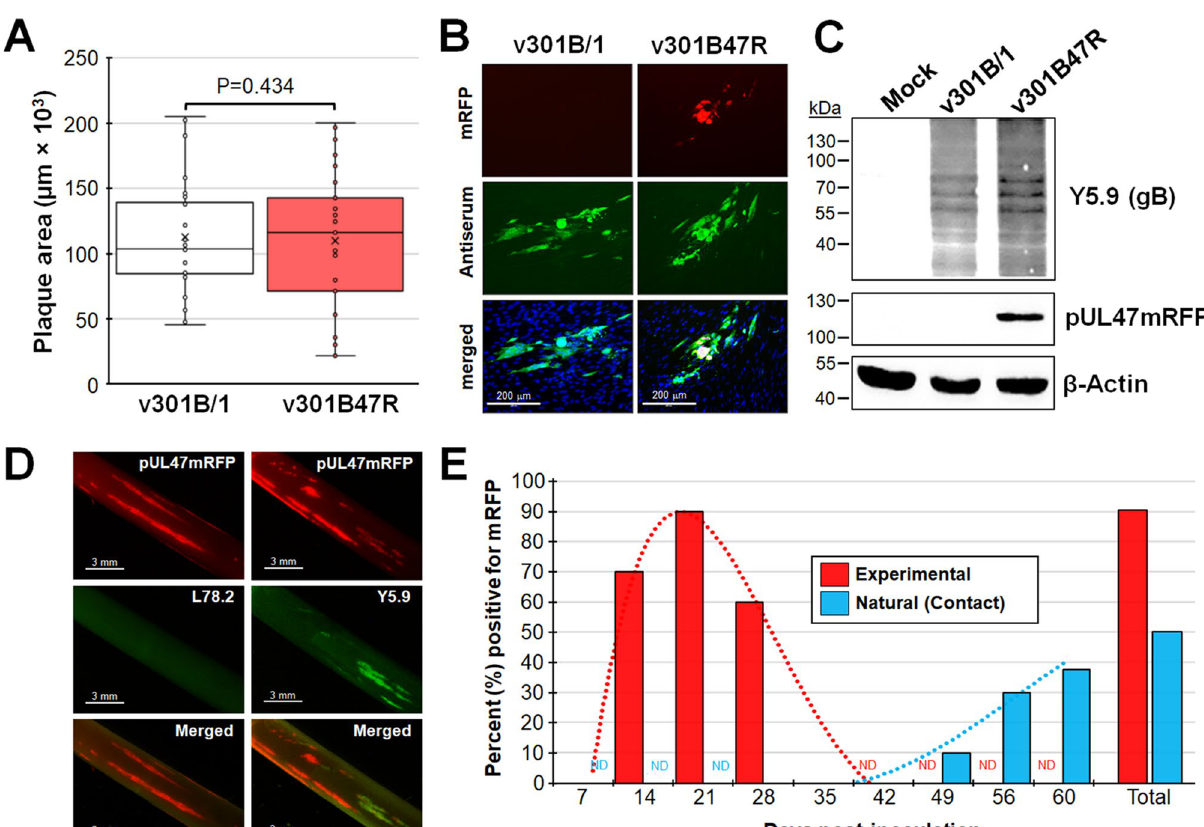
Figure 2. Replication and fluorescent protein expression in tissue culture cells. ( A ) Mean plaque areas (n = 25) of viruses reconstituted from r301B/1 and r301B47R were measured and the results are shown as box & whisker plots. There were no significant differences in plaque sizes between the two viruses using Student’s t tests. ( B ) Representative plaques for v301B/1 and v301B47R are shown. Plaques were stained with polyclonal chicken anti-GaHV-3 antibody and goat anti-chicken-IgY Alexa488 (green) was used as secondary antibody to identify plaques. Fluorescent expression of mRFP (red) was directly visualized and cells were counterstained with Hoechst 33342 to visualize nuclei. ( C ) Western blotting for pUL47mRFP using anti-mRFP antibody. The anti-GaHV-3 antibody Y5.9 31 was used to show the relative level of infection in the cultures. Antibody against chicken β-actin is shown as a loading control. ( D ) Fluorescent protein expression in feather follicles (FFs) infected with v301B47R at 21 dpi. FFs were also stained with anti-HVT L78.2 or -GaHV-3 Y5.9 plus anti-mouse IgG-Alexa488 (green) and images were collected with a fluorescent stereoscope. ( E ) Percent of chickens positive for pUL47mRFP in experimental and naturally (contact) infected chickens over 60 days. ND not